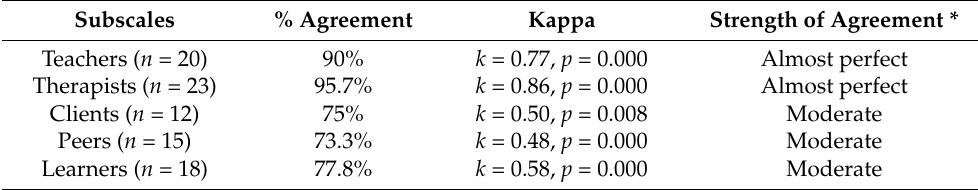
Table 2. Percentage agreement and kappa scores for the subscales of the MPC. Subscales Kappa